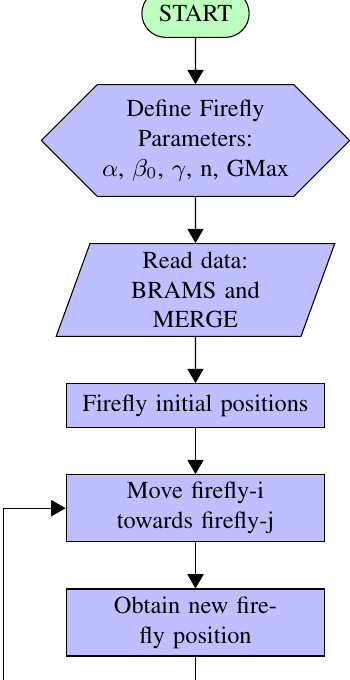
Table 1. Parameter values used in the FY.